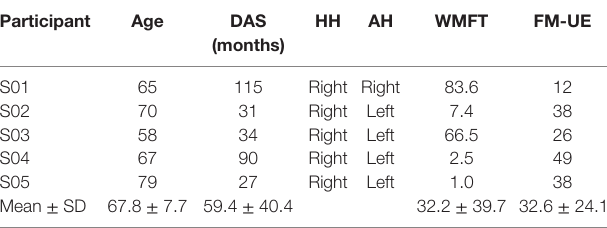
TaBle 4 | stroke participant information.